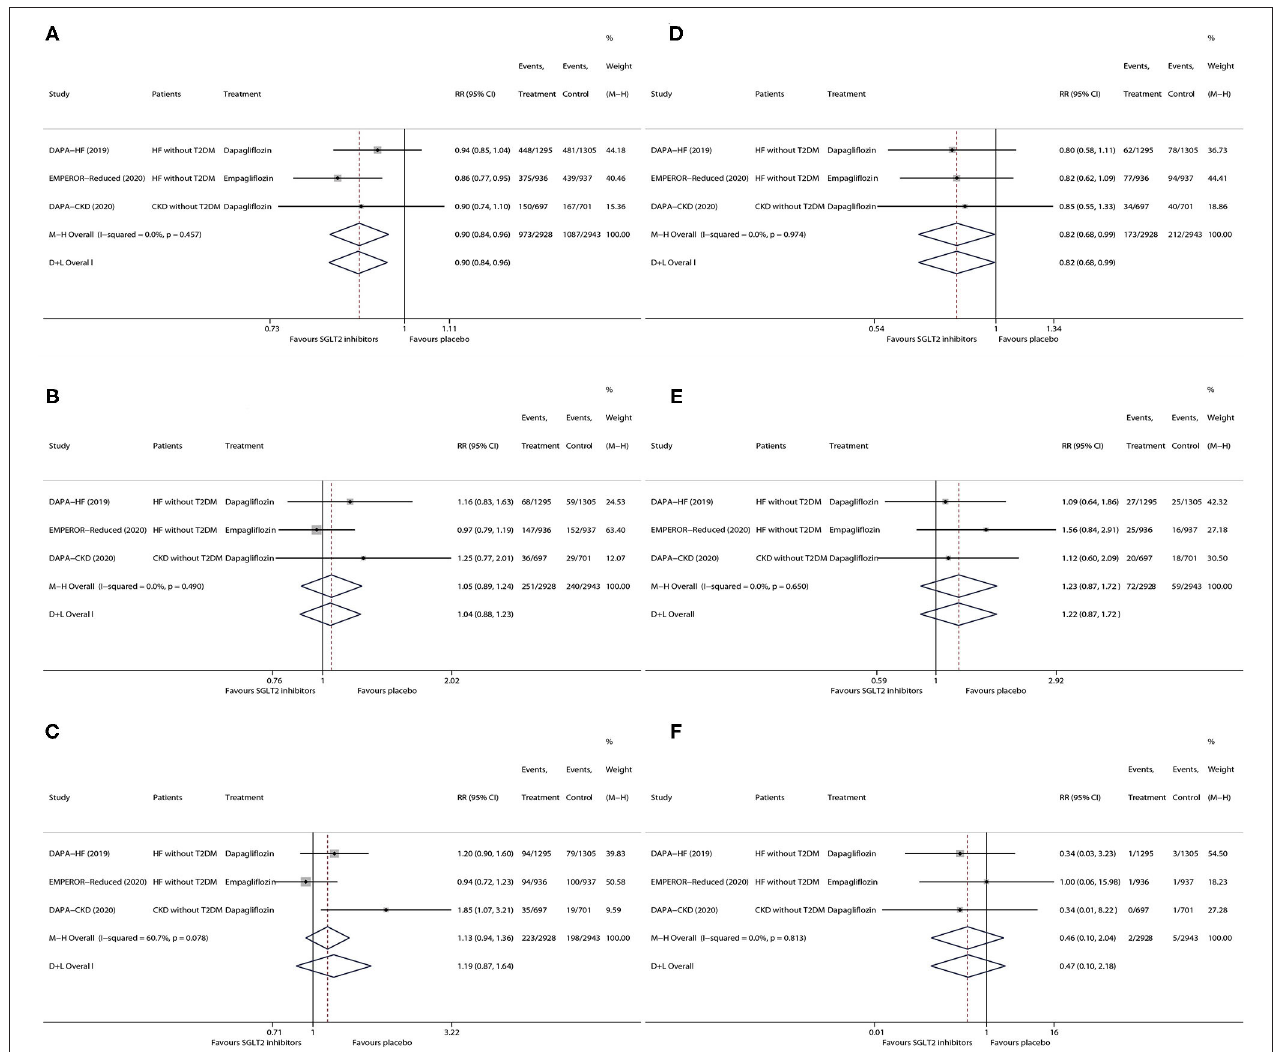
FIGURE 2 | Meta-analysis of the effects of SGLT2 inhibitors on any serious adverse event (A) , discontinuation of study drug due to adverse event (B) , volume depletion (C) , kidney adverse event (D) , fracture (E) , and amputation (F) in patients without T2DM. SGLT2, sodium-glucose cotransporter 2. HF, heart failure; T2DM, type 2 diabetes mellitus; CKD, chronic kidney disease; RR, risk ratio; CI, confidence